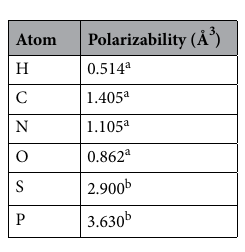
b Values from Ref. 38